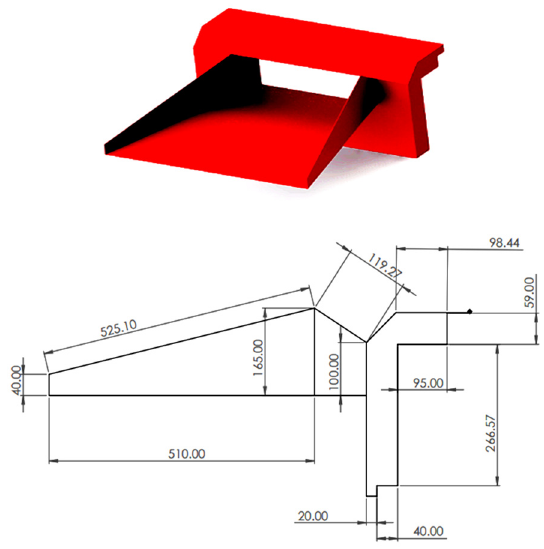
Figure 5. Isometric view of the feeding tray of the Aashkol.